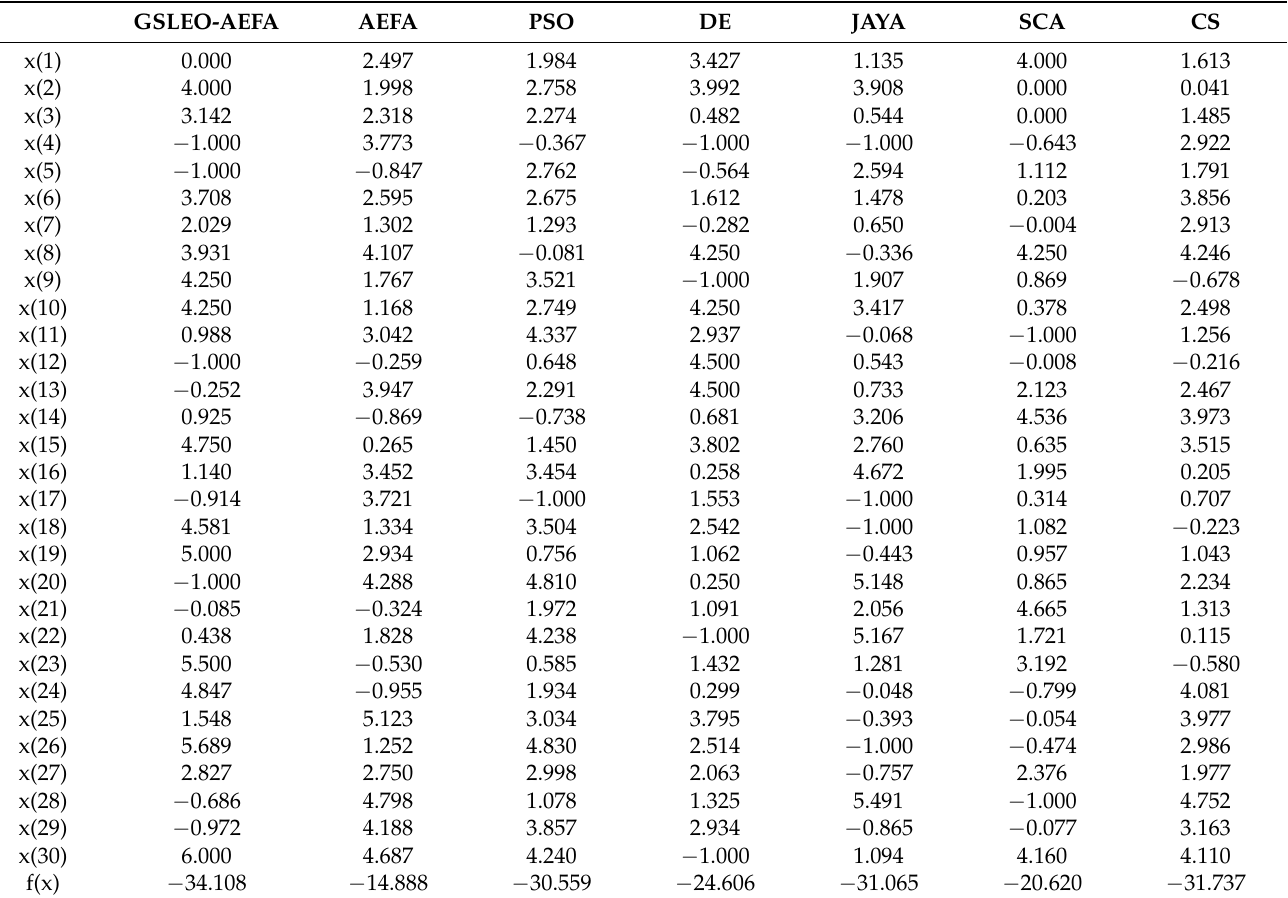
Table 11. Results of Tersoff Potential Function Minimization